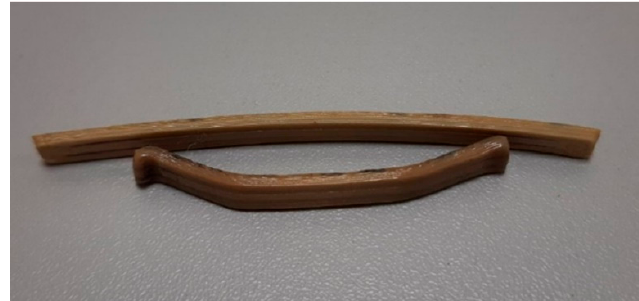
Figure 8. PEEK sample before and after DMA experiment.